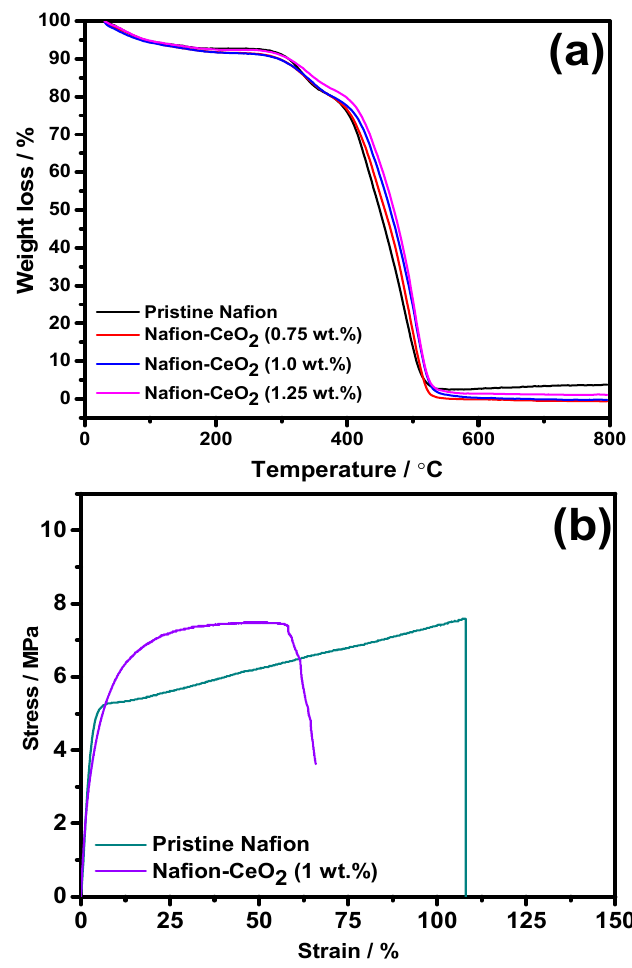
Figure 4. ( a ) Thermogravimetric analysis of pristine Nafion and Nafion-CeO 2 composite membrane; ( b ) Tensile strength of pristine Nafion and Nafion-CeO 2 (1 wt. %) composite membrane.